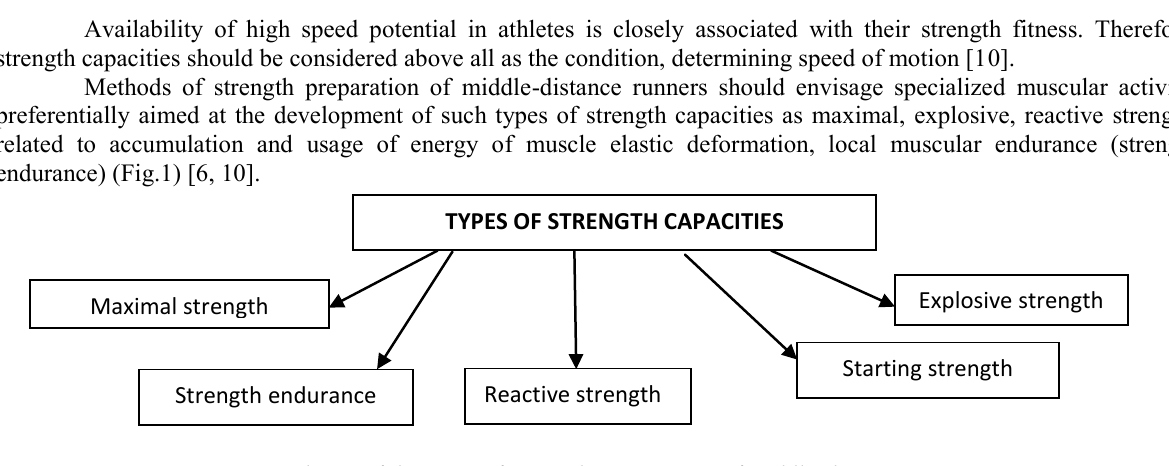
Fig. 1. Scheme of the types of strength preparation of middle-distance